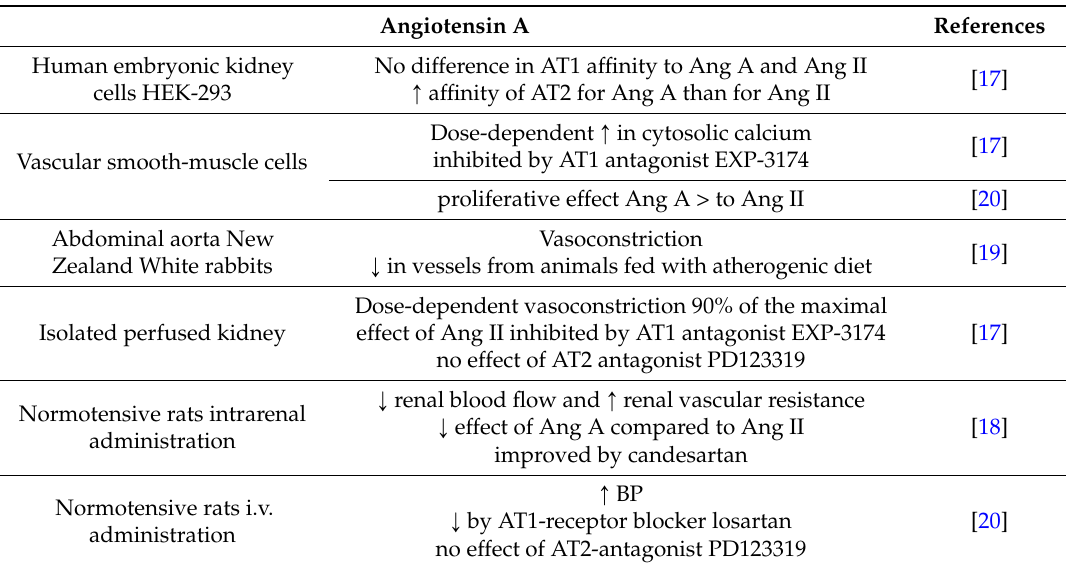
Table 1. Bilogical effects of Angiotensin